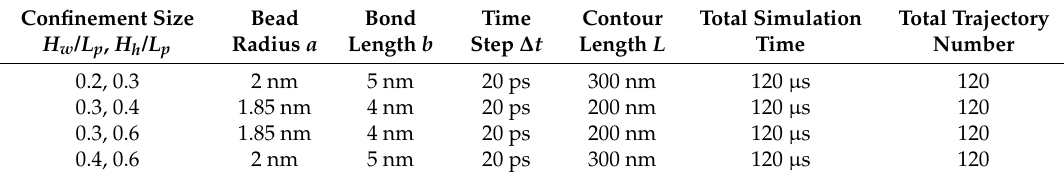
Table 4. Simulation parameters for the confinement of rectangular tubes.